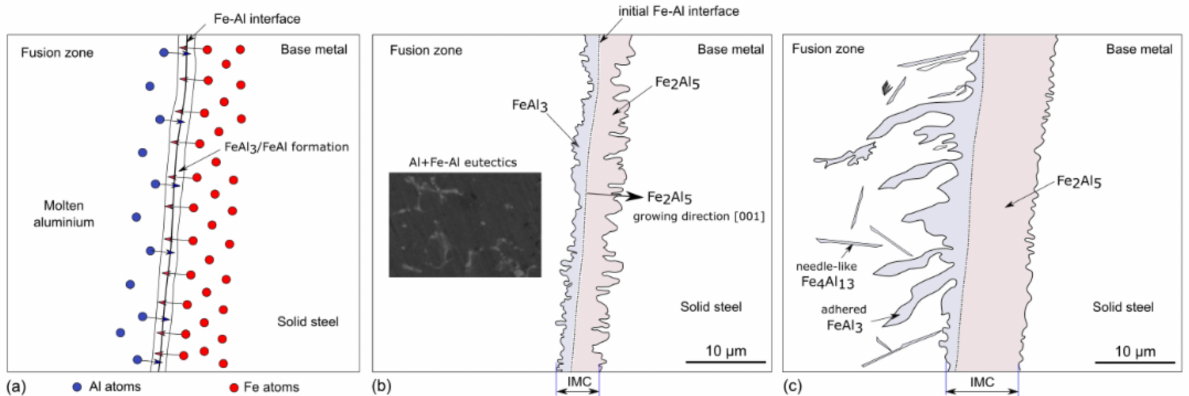
Figure 10. Formation and growth of Fe-Al IMC layer during welding according to progress in weld thermal cycle: ( a ) initial formation of FeAl phases; ( b ) Fe x Al x phases during low heat input parameters; and ( c ) Fe x Al x phases during high heat input. Figure is based on